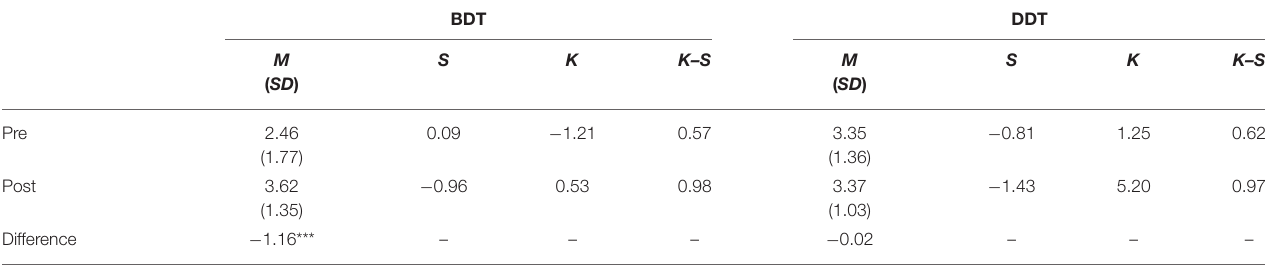
TABLE 6 | Discrimination sensitivity ( d ′ ) of BDT and DDT before and after the mindfulness training in elite shooting athletes of the national team ( n = 27).